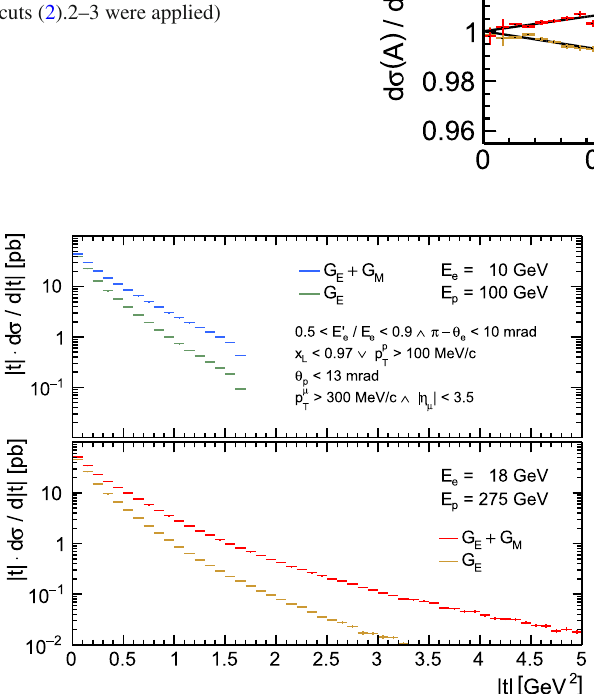
Fig. 4 Ratios of the observed cross-sections d σ/ d t for A = 0 . 69 GeV 2 and 0.73 GeV 2 with respect to the “standard” d σ/ d t ( A 0 ) ; statistical errors correspond to the integrated luminosity of 106 and 99 fb − 1 for low (upper plot) and high (lower plot) energy beams, respectively. The fitted slopes at t ≈ 0 are also displayed. Neither electron requirement nor the photon veto were imposed (only cuts (2).2–3 were applied)